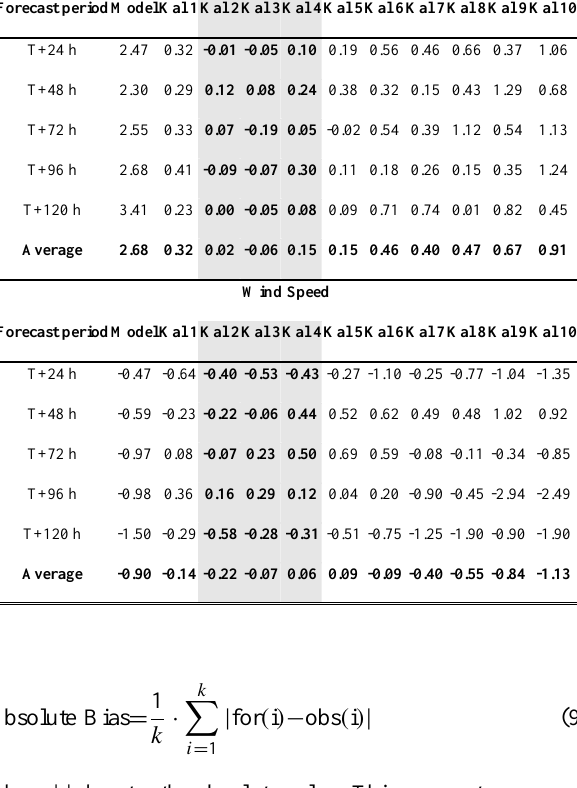
Table 2. Absolute Biases of direct model output and Kalman filters – Case I. TABLE 2 . Absolute Biases of direct model output and Kalman filters – Case I